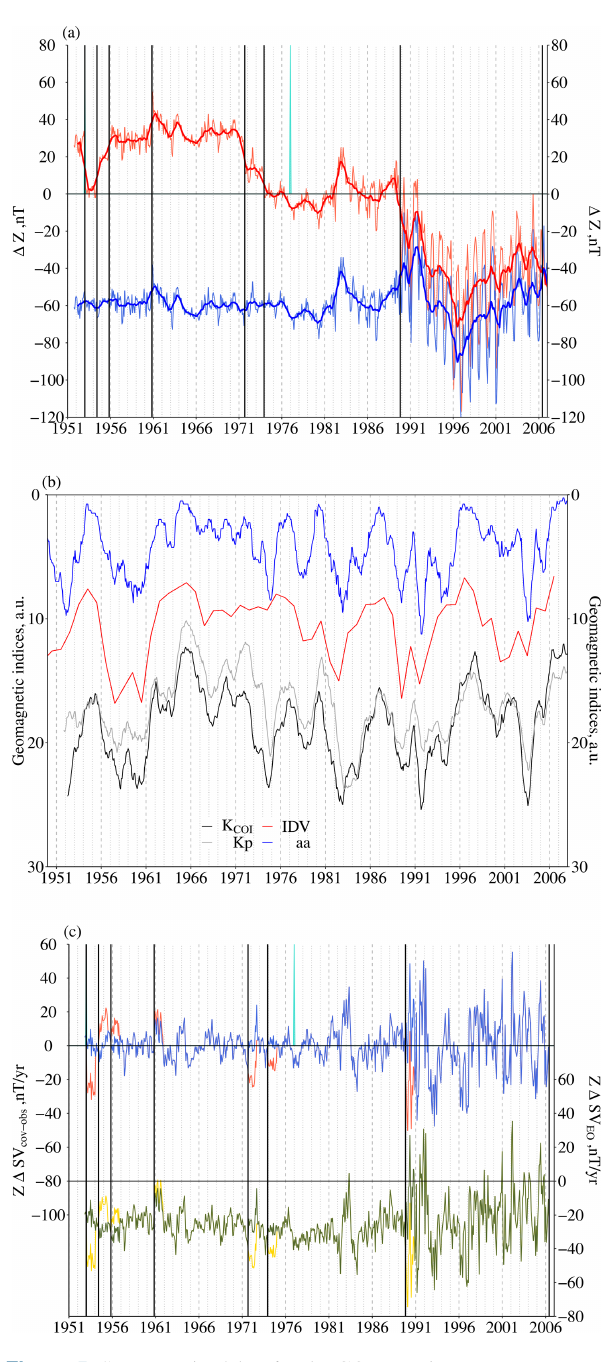
Figure 5. Same as Fig. 3 but for the COI Z series.